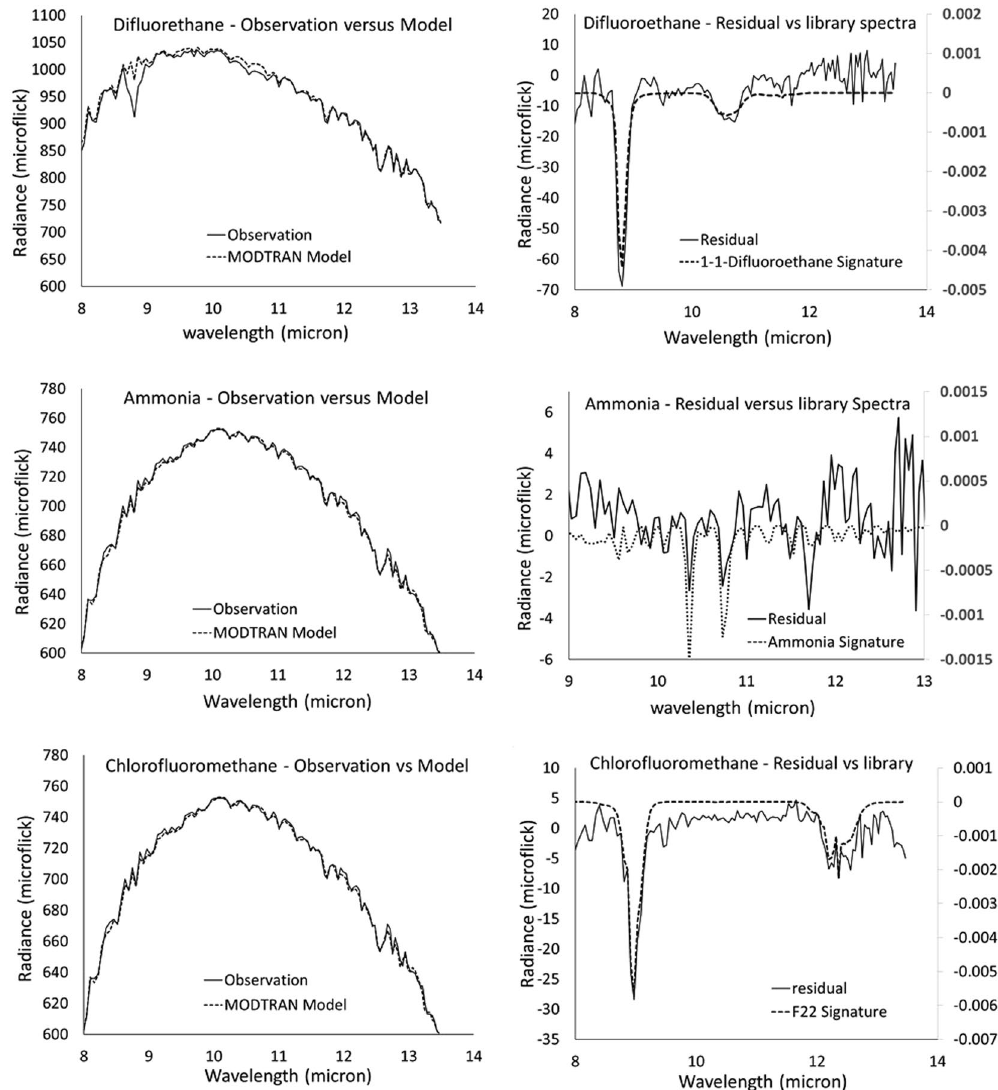
Figure 5. Top (control release, Difluoroethane), Middle (Ammonia), Bottom (Chlorodifluoromethane). (Left) Measured versus modeled path radiance, (Right) Library spectra versus residual calculated after correction for atmosphere, and removal of estimated surface temperature. It is important to note the presence of strong water absorption lines at 11.7 and 12.9 microns, as well as weaker water lines at 11.9, 12,1, 12.3 and 12.5 microns in the Ammonia residuals versus library spectra